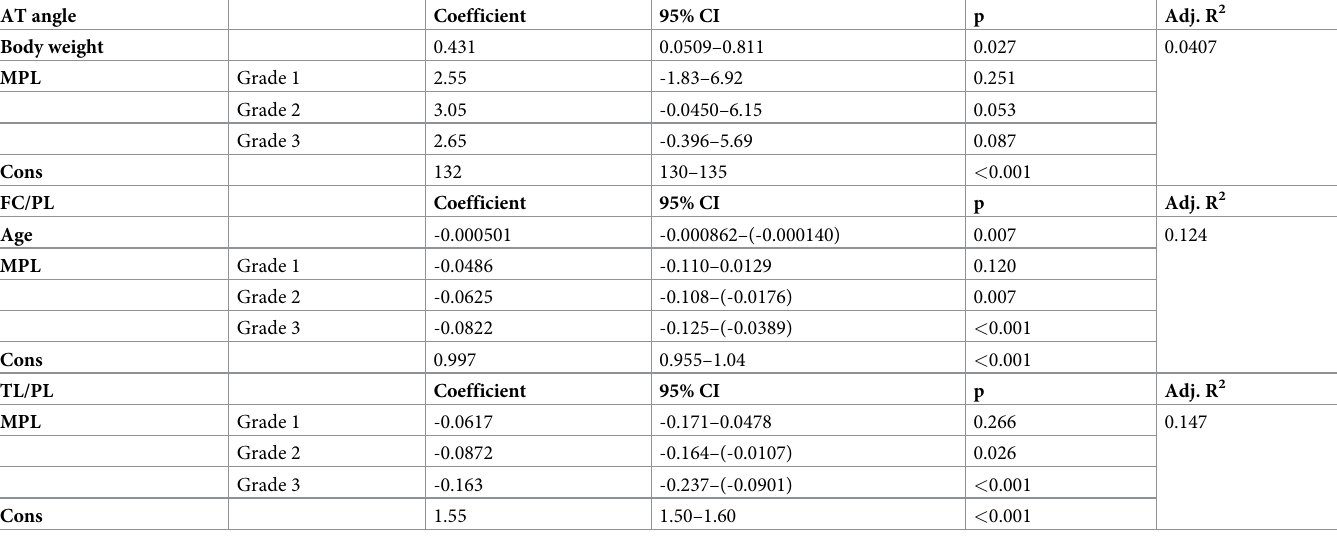
Table 8. Final models of multivariable linear regression analyses for AT angle, FC/PL, TL/PL or TL/FC, and the grade of